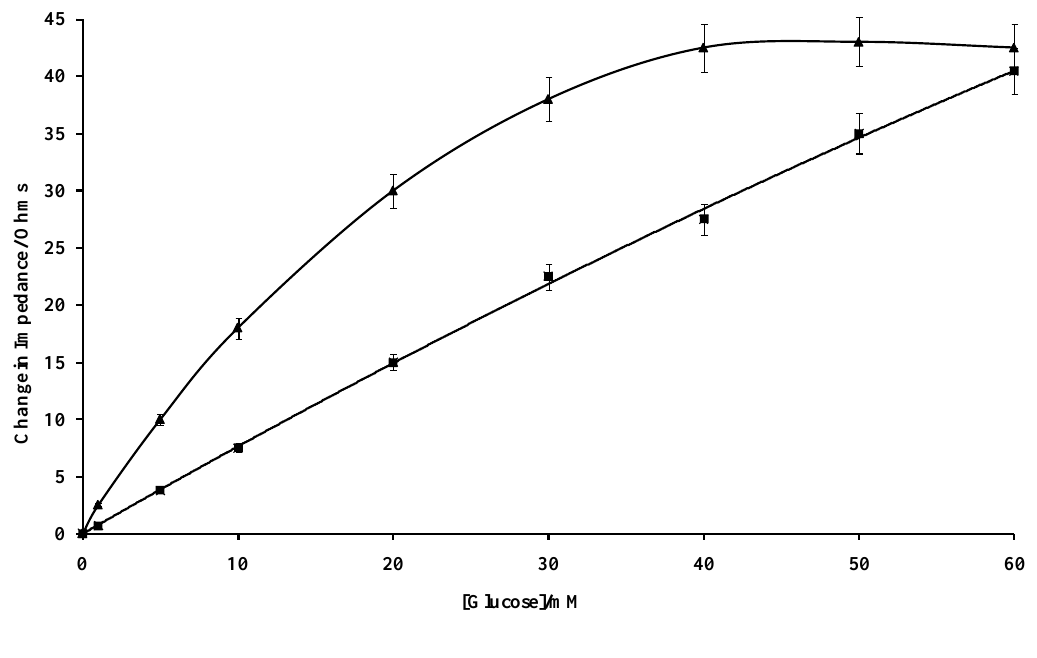
Figure 18. AC impedance calibration plot for glucose oxidase microelectrode arrays: uncoated (  ), with poly(siloxane) coating ( 